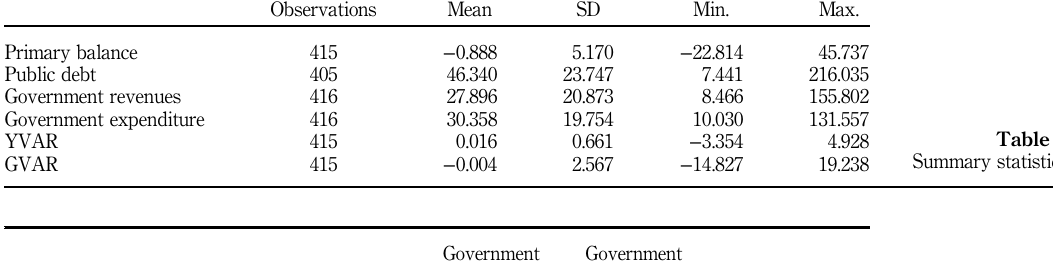
Table I. Summary statistics